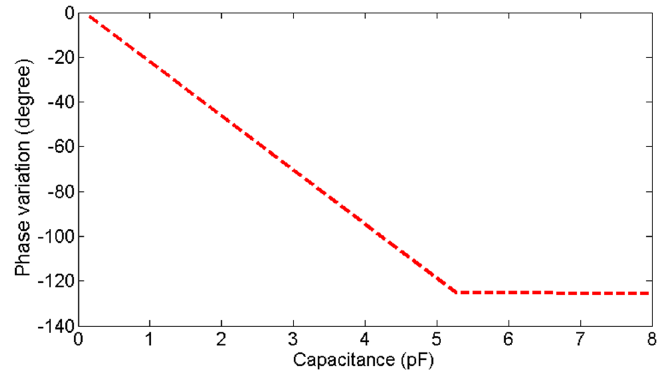
Figure 4. Phase variation of the 3-dB coupler by applying different capacitance values at ports 3 and 4.